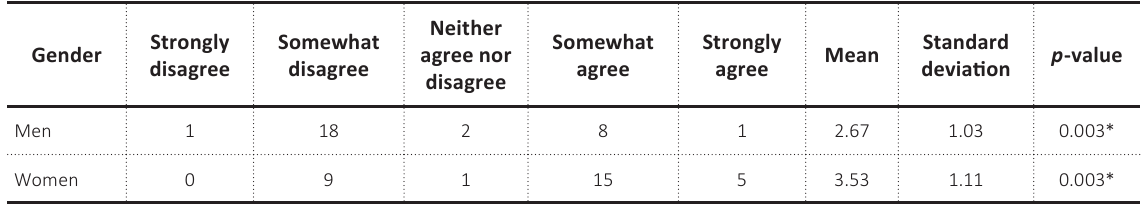
Table 1. I feel I am being paid a fair amount for the work I do